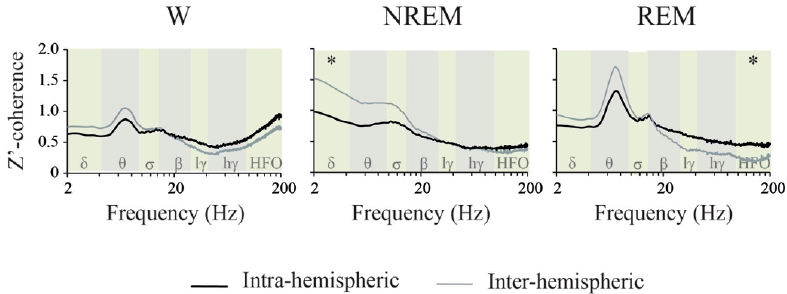
Figure 7. Z’-coherence differences between intra- and inter-hemispheric derivations. z’-coherence profile of the mean intra-hemispheric (OB-M1, M1-S1 and S1-V2) and inter-hemispheric (right–left M1, S1, V2) derivations during wakefulness (W), NREM and REM sleep in the light phase ( n = 11). The analyzed frequency bands are indicated by different colors in the background of the graphics. OB, olfactory bulb; M1, primary motor cortex; S1, primary somato-sensory cortex; V2, secondary visual cortex; r, right; l, left; l γ , low gamma or LG; h γ , high gamma or HG; HFO, high frequency oscillations. Asterisks indicate significant differences, p < 0.05. M1, primary motor cortex; S1, primary somato-sensory cortex; V2, secondary visual cortex; l γ , low gamma or LG; h γ , high gamma or HG; HFO, high frequency oscillations.